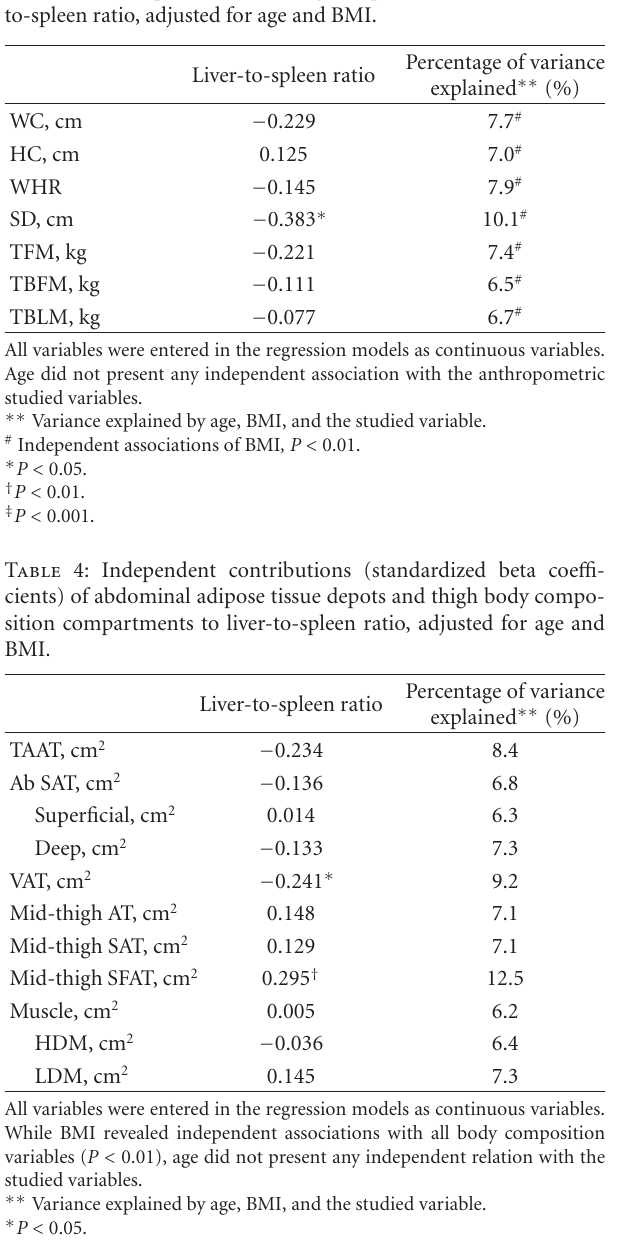
Table 2: Metabolic syndrome characteristics of the study popula- tion ( n = 140).